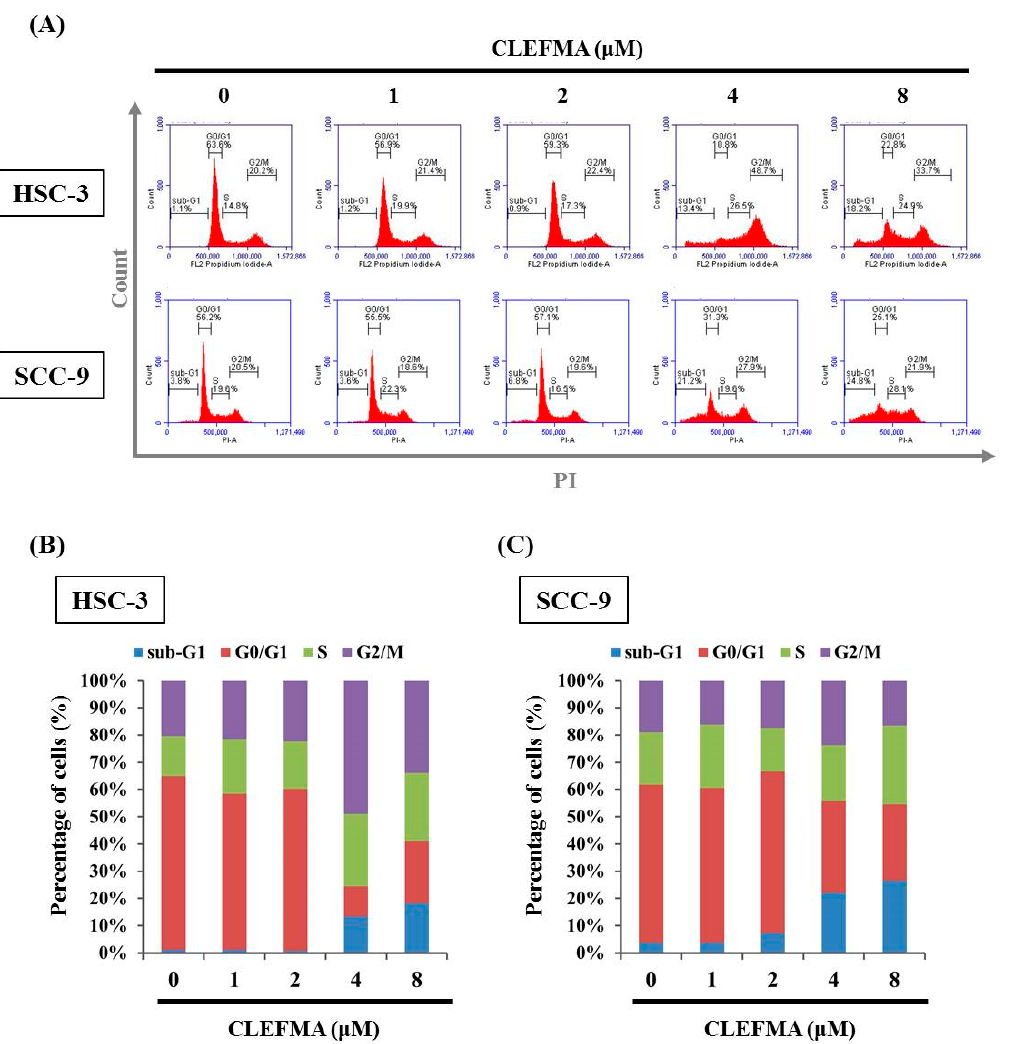
Figure 2. CLEFMA increased the sub-G1 phase ratio in human OSCC. ( A ) HSC-3 and SCC-9 cells were incubated with CLEFMA at indicated concentrations for 24 h and then incubated with a PI buffer. After staining, the cells were subjected to cell cycle distribution analysis via flow cytometry. The quantification results of the cell cycle population of ( B ) HSC-3 and ( C ) SCC-9 cells are shown in the bar graph. Quantification analysis was acquired from three independent experiments and expressed as mean ± SD. * represent p < 0.05 as compared with the 0.1% DMSO control.